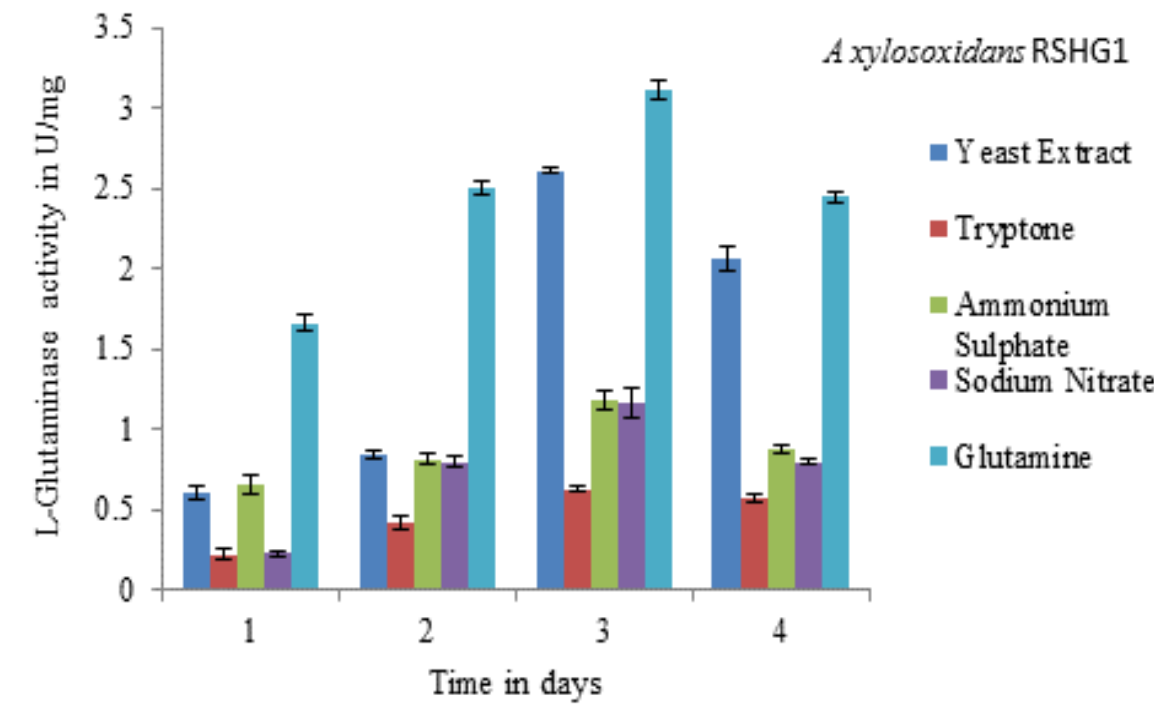
Figure 6. Effect of carbon source on Glutaminase production by A. xylosoxidans RSHG1 on fermentation medium at 30 ◦ C, pH 9.